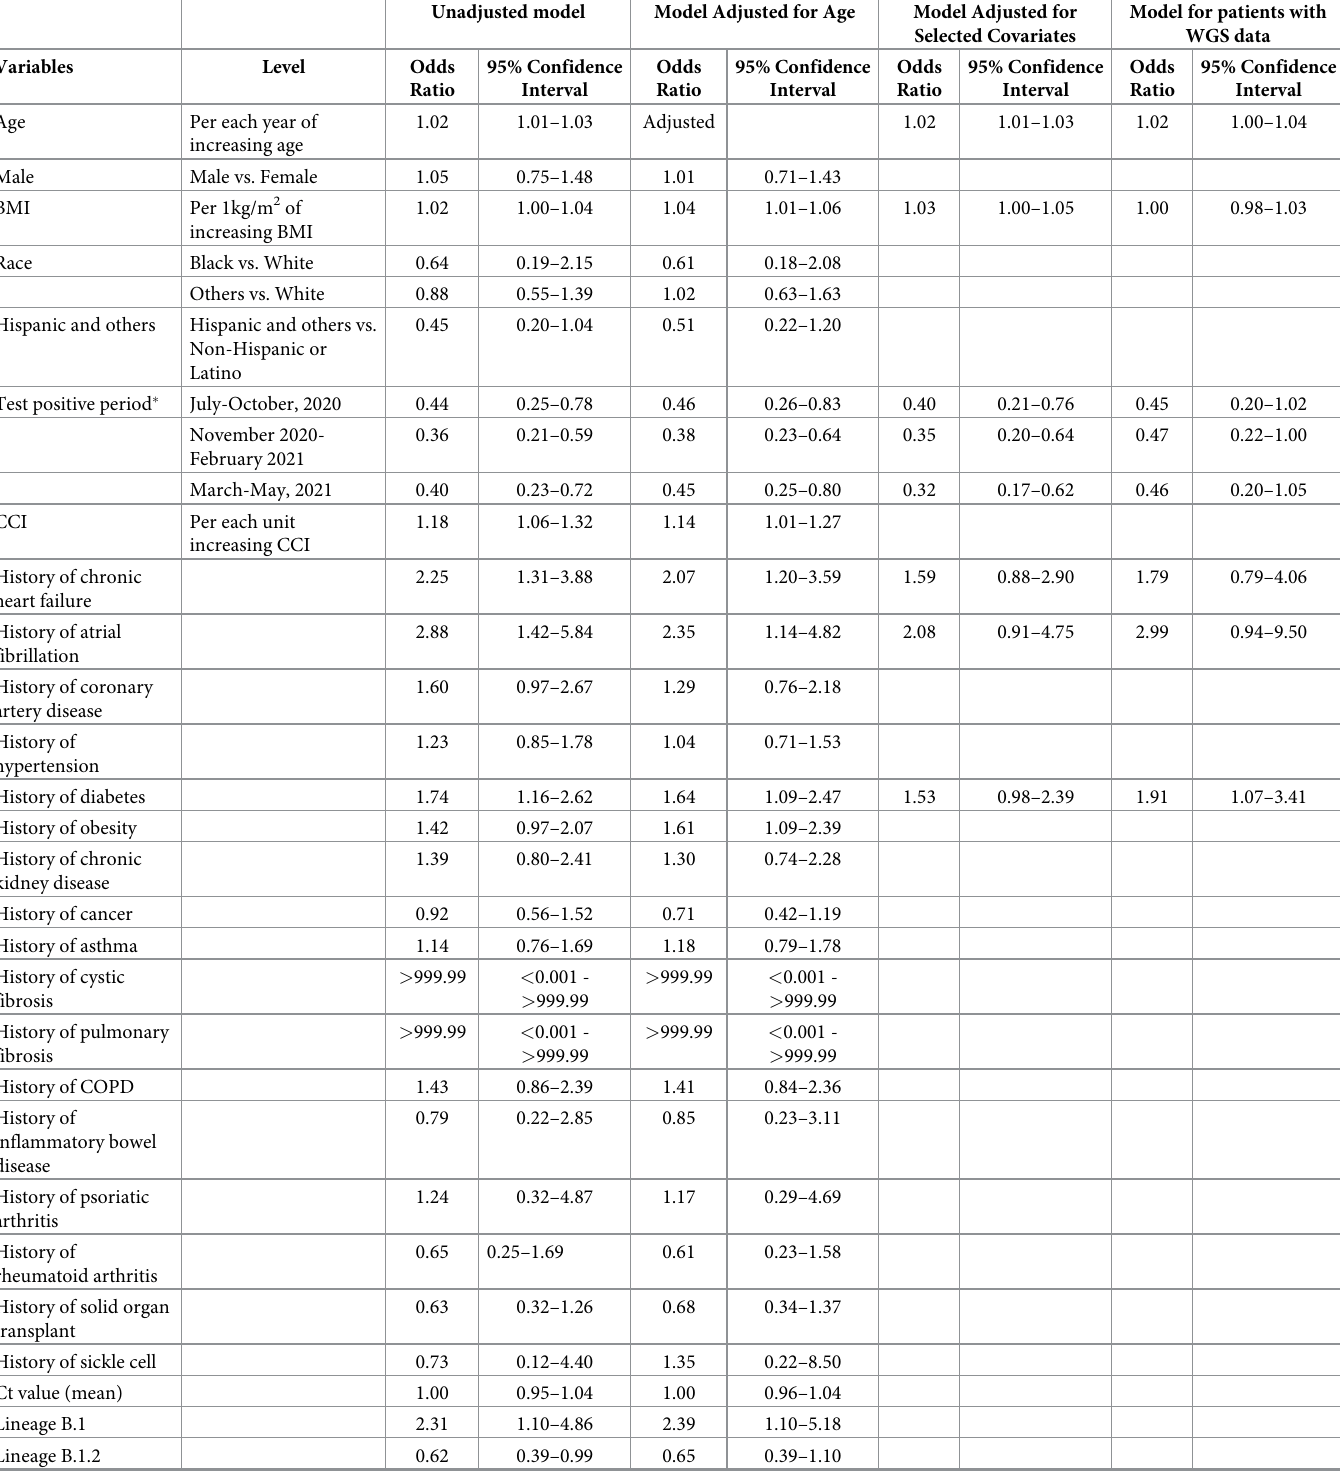
Table 3. Predictive models for risk of severe COVID-19 among UPMC inpatients.